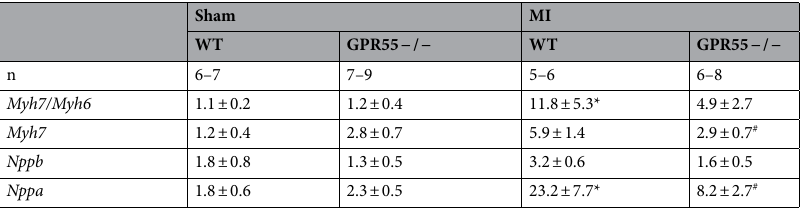
Table 2. LV foetal gene re-expression 1 day after surgery in WT and GPR55 − / − mice. Mean ± SE; *p < 0.05 vs. corresponding Sham, # p < 0.05 vs. corresponding WT, two-way ANOVA with Sidak’s post hoc